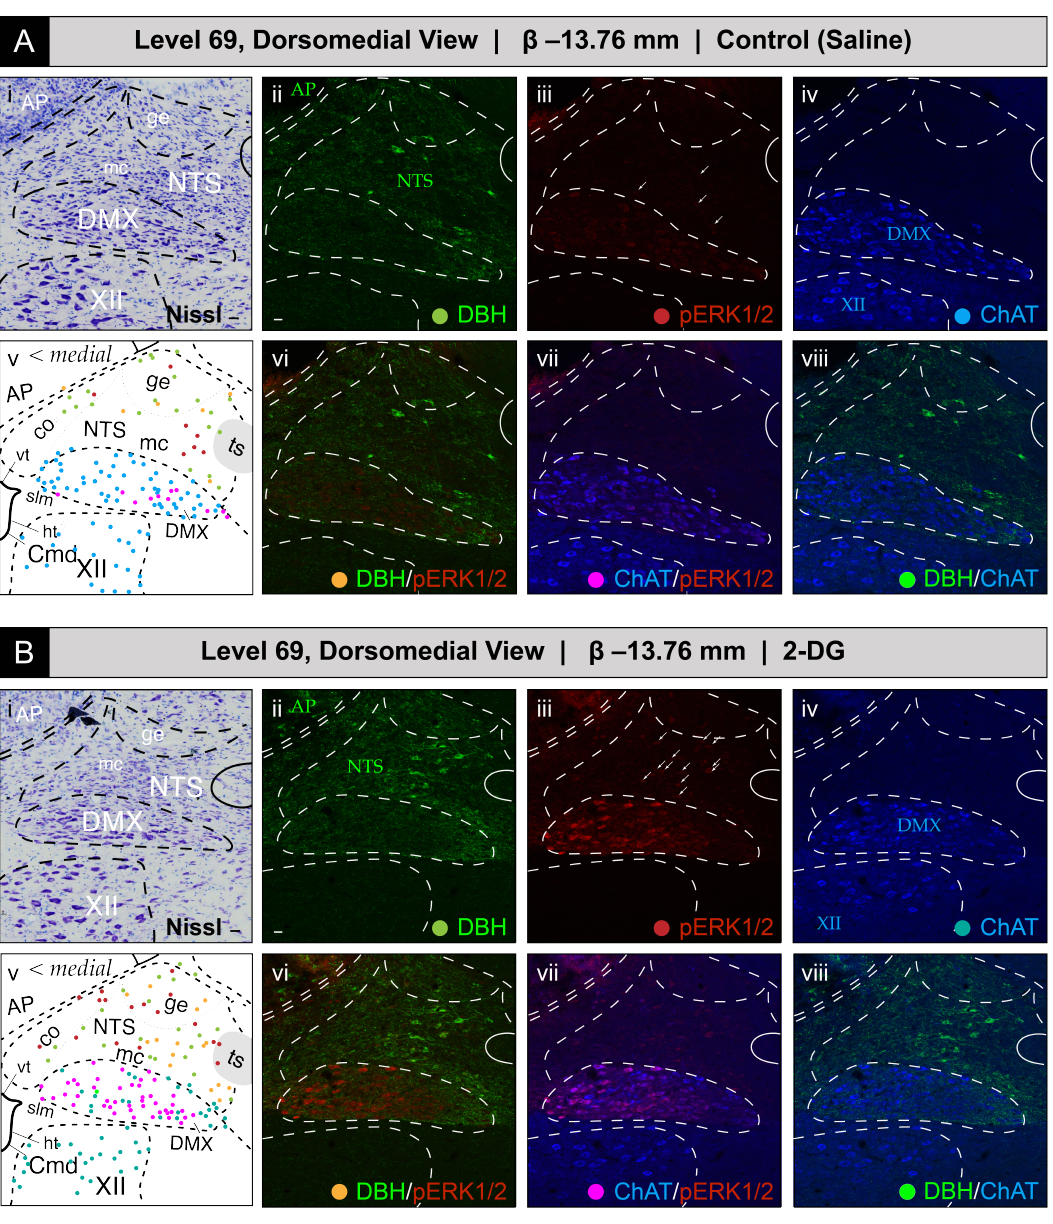
Figure 8. Glycemic challenge is associated with the recruitment of dorsal medulla (Winslow, 1733) [42] (MY) neurons mapped to atlas level 69 of Brain Maps 4.0 (BM4.0) [81] at the level of the area postrema (>1840) (AP). Cytoarchitecture- and chemoarchitecture-based spatial analysis of immunoreactivity patterns for dopamine β -hydroxylase (DBH, green ), phospho-ERK1/2 (pERK1/2, red ), and choline acetyltransferase (ChAT, blue ) within dorsal MY neurons. ( A , B ) The panels display coronal-plane Nissl photomicrographs ( i ), single- ( ii – iv ) and dual-channel ( vi – viii ) fluorescence images, and BM4.0 atlas maps ( v ) for saline- (( A ); Subject K10-011) and 2-DG-treated (( B ); Subject K10-026) subjects. The patterns fall near or within the boundaries for the AP, nucleus of solitary tract (>1840) (NTS), dorsal motor nucleus of vagus nerve (>1840) (DMX), and hypoglossal nucleus (>1840) (XII). Arrows in ( Aiii , Biii ) mark perikaryon profiles immunoreactive for pERK1/2 in the NTS. Colors for the AP, NTS, DMX, and XII labels match those of the labeling patterns used to help define their boundaries. Scale bars in ( i , ii ), which mark 20 µ m, and the medial orientation noted in ( v ), apply to all images. Headers for ( A , B ) note the inferred anteroposterior stereotaxic coordinate, expressed as millimeters from the bregma ( β ) skull suture. See the list of abbreviations at the end of this article for a description of those marked on the